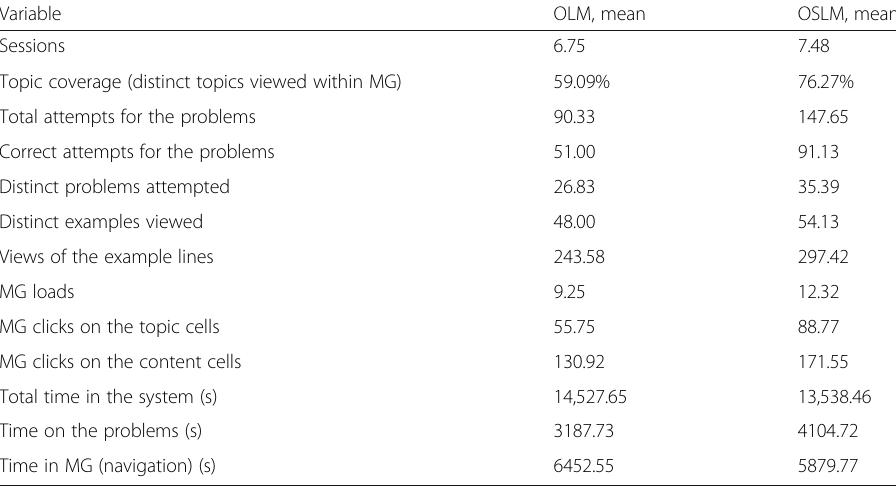
Table 4 System usage by the OLM and OSLM groups in study 2